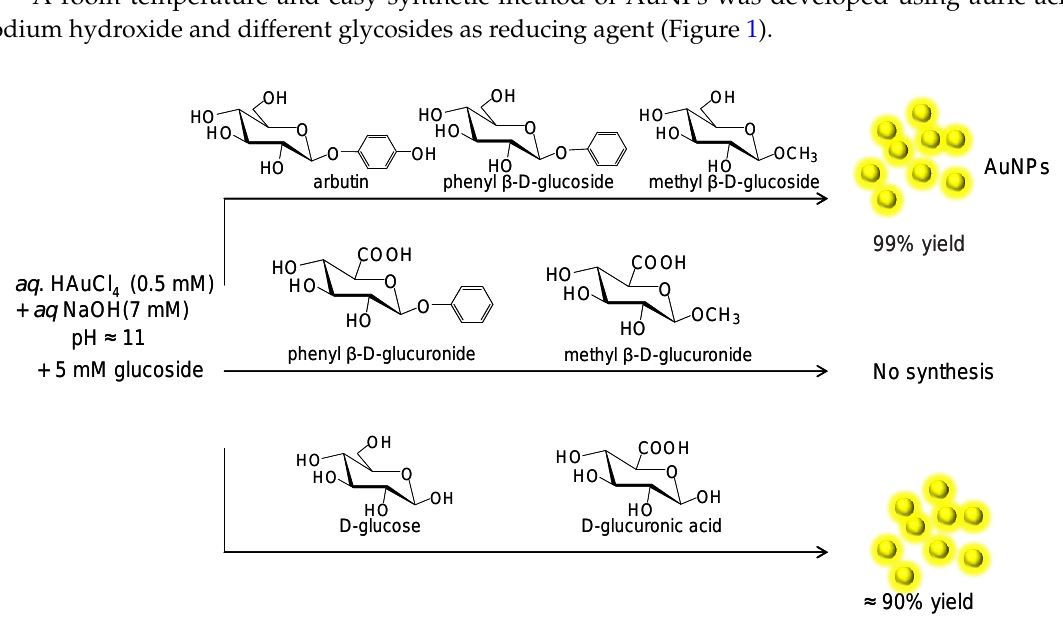
Figure 1. Synthesis of gold nanoparticles (AuNPs) induced by different glucose derivatives.